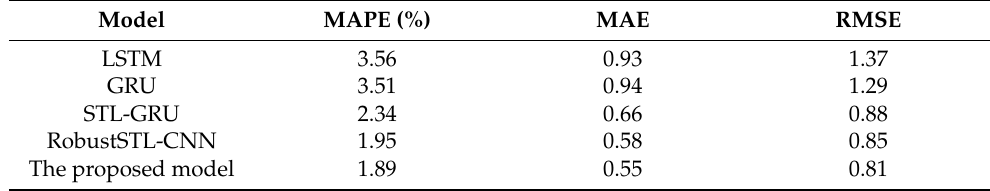
Table 1. The results of comparison between the proposed model and counterpart